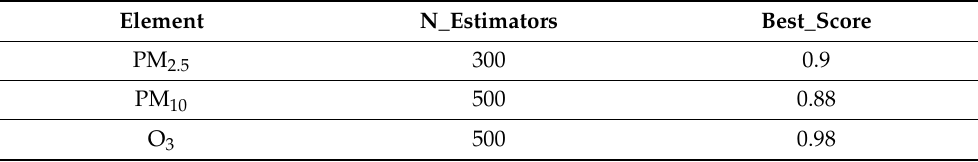
Table 5. XGB Optimal